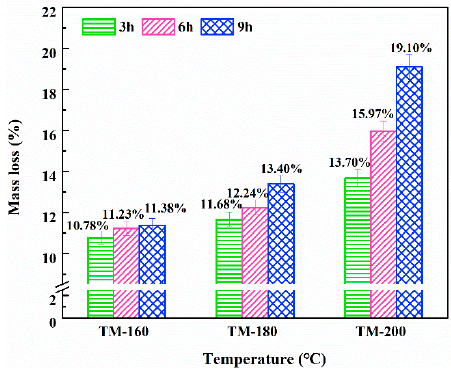
Figure 2. Effects of thermal treatment on the mass loss of wood. Figure 2. E ff ects of thermal treatment on the mass loss of